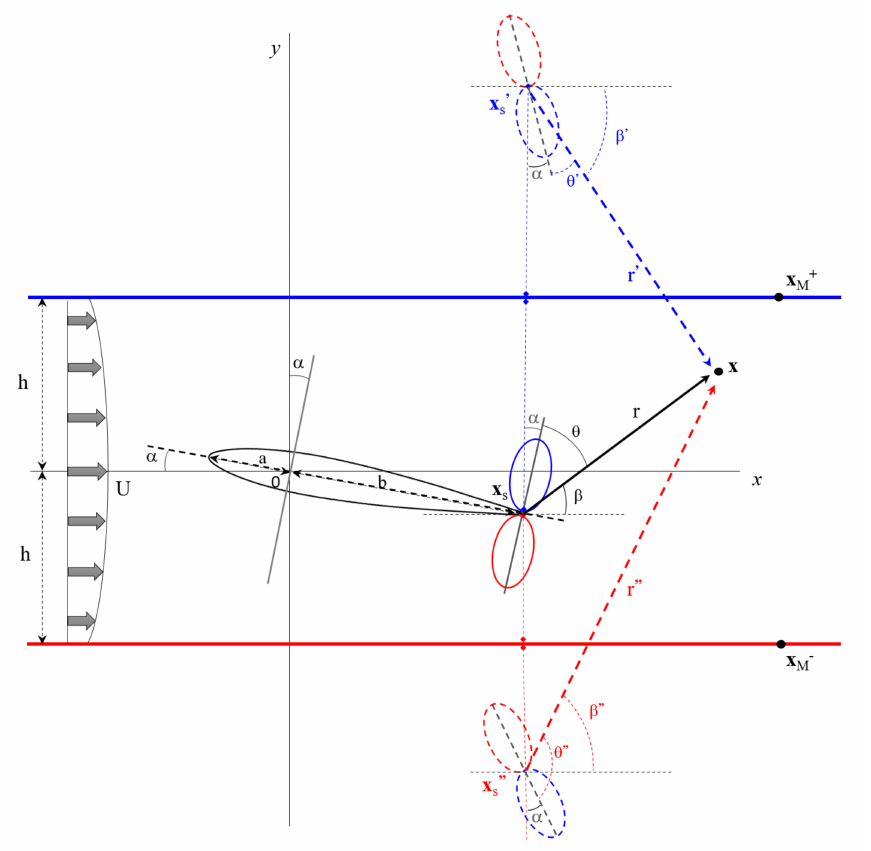
Figure 1. Sketch of the experimental set-up, with geometrical construction of the specular reflections using source